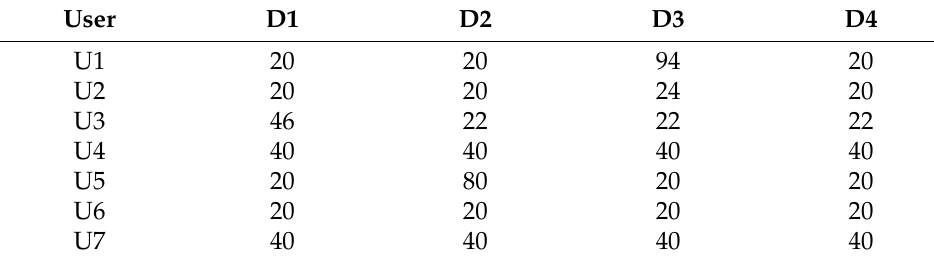
Table 1. Number of recordings acquired per each user and each device.